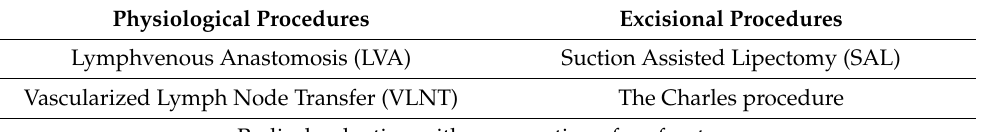
Table 1. Surgical approaches applied in lymphedema patients. Physiological